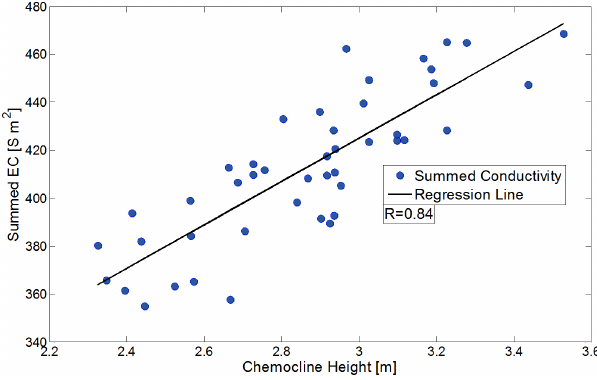
Figure 8. Correlation between summed conductivity and chemo- cline height. A linear regression results in a correlation coefficient of